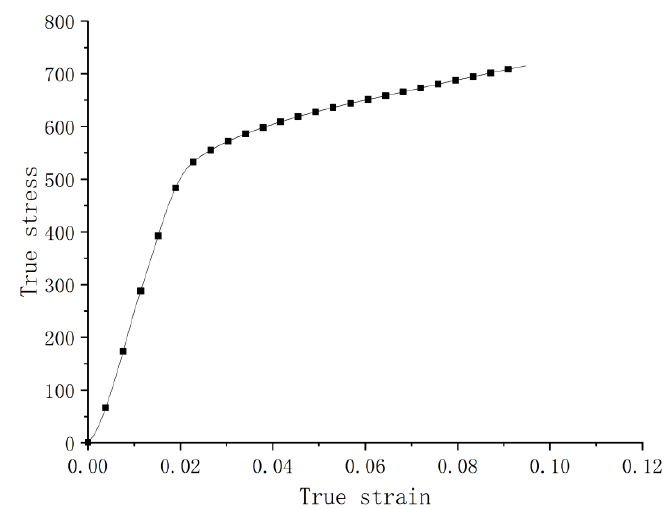
Figure 4. Stress–strain curve by tension at the strain rate 0.001 s − 1 .